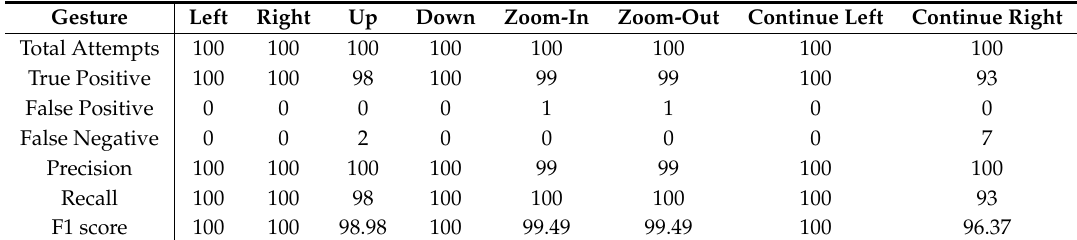
Table 1. Experiment results of precision error, recall error, and F1 score about each gesture of 10 subject at 35–50